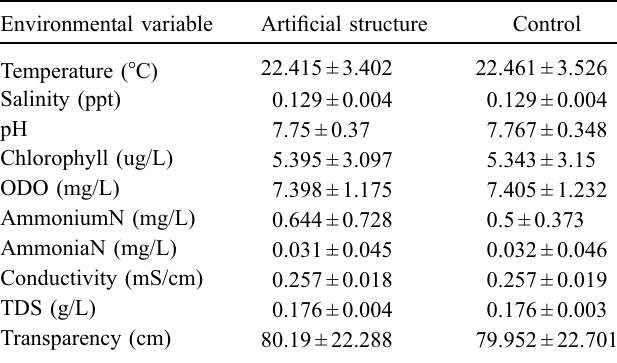
Table 1. Environmental variables (mean± SD) measured seasonally, from December 2014 to June 2016, at the arti fi cial structure and control site. ODO: dissolved oxygen, TDS: total dissolved solids